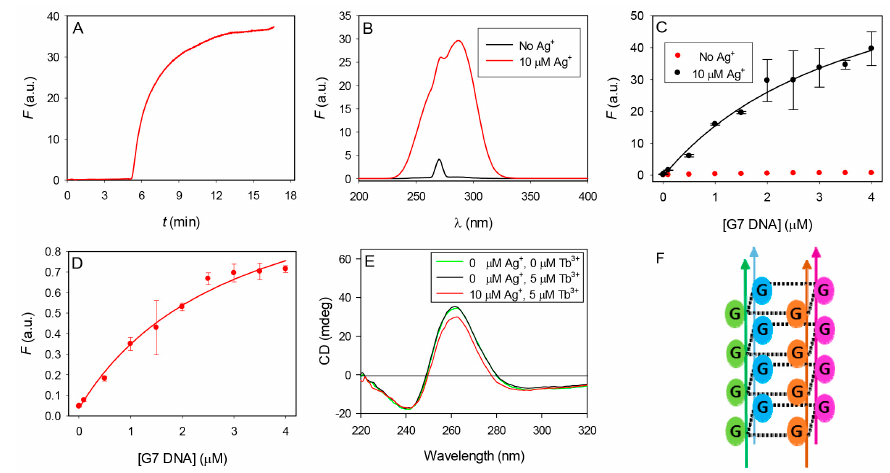
Figure 3. Mechanistic studies. ( A ) Kinetics of emission change upon addition of 10 µM Ag + at 5 min; ( B ) Fluorescence excitation spectra of Tb 3+ (5 µM) and G7 (1 µM) in the absence and presence of 10 µM Ag + in 50 mM HEPES pH 7.5 buffer by monitoring emission at 543 nm; ( C ) Titration of G7 to Tb 3+ in the absence and presence of Ag + ; ( D ) The red trace in ( C ) at a smaller y -axis scale to determine the K d values based on F = F 0 + aC /( K d + C ), where F and F 0 are the current and initial fluorescence intensity, respectively, C is added DNA concentration, and a is the final fluorescence enhancement at infinitely high DNA concentration; ( E ) The CD spectra of 1 µM G7 DNA in 50 mM HEPES pH 7.5 and upon the sequential addition of 5 µM Tb 3+ and then 10 µM Ag + ; ( F ) A general schematic of the four-stranded parallel G-quadruplex structure.